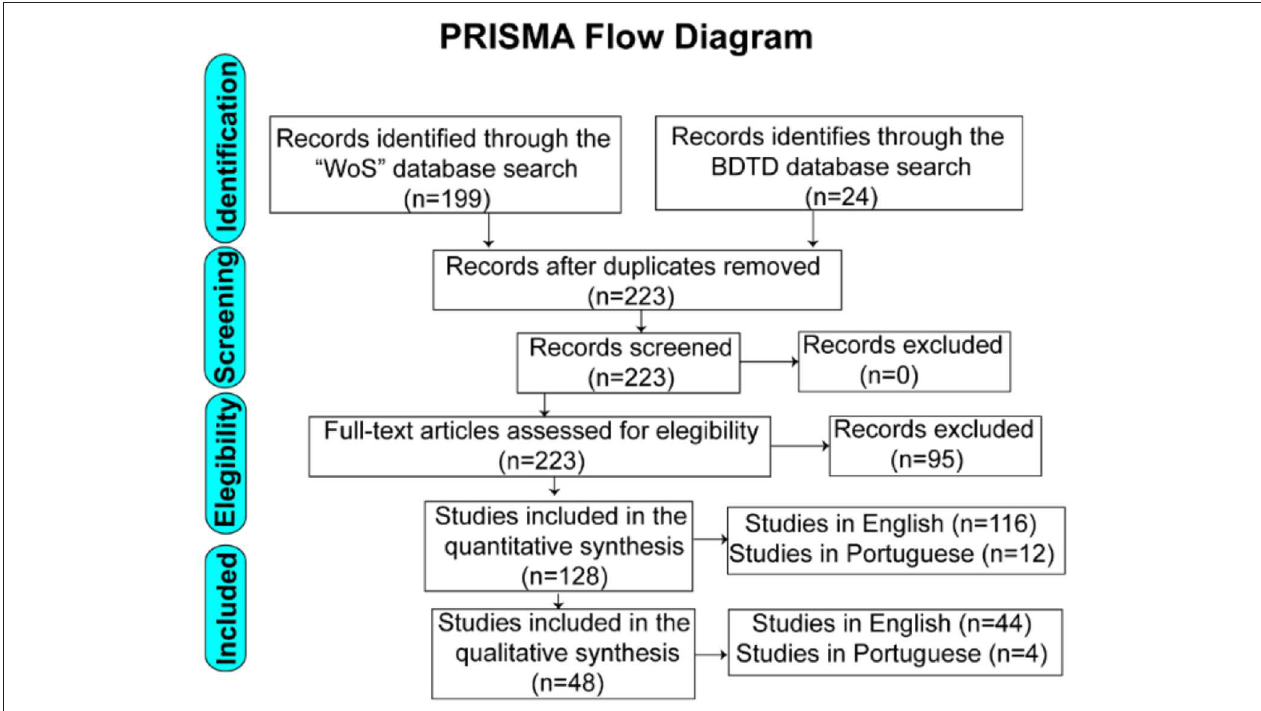
FIGURE 3 | Diagram of selection and eligibility criteria, including sample sizes, using the PRISMA report. The PRISMA report was used to filter documents obtained from the databases according to the eligibility